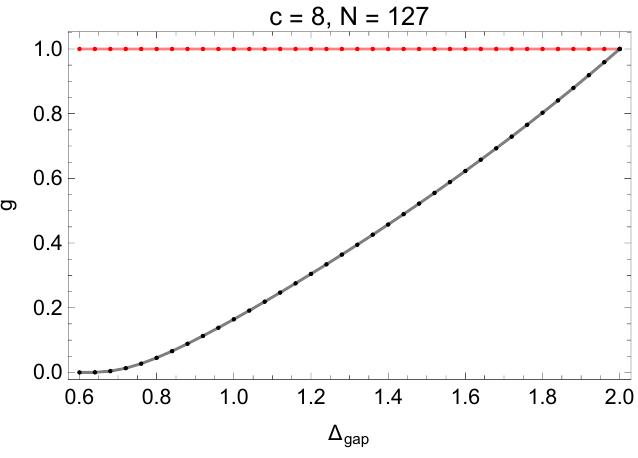
Figure 8. Upper (red) and lower (black) bounds on the g -function for stable boundary conditions in c = 8